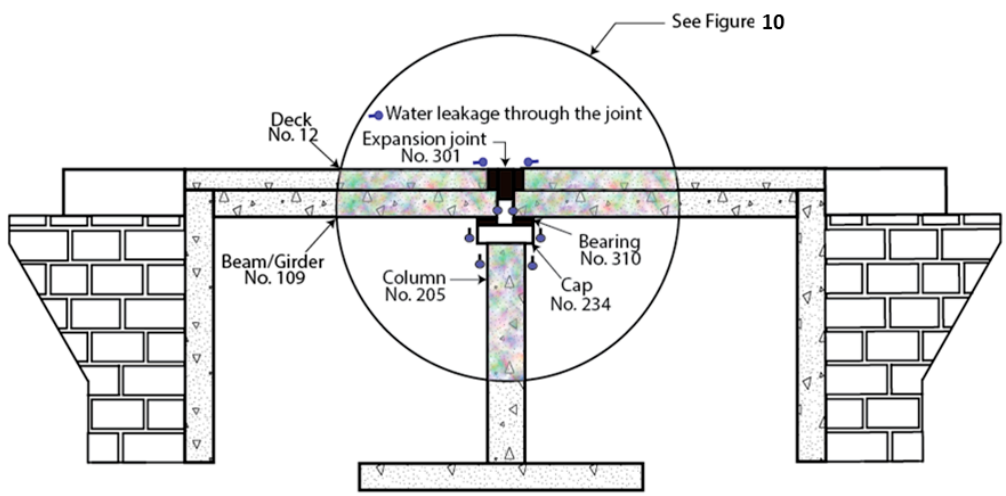
Figure 9. A two-span bridge with a group of Co-Active elements in the group PC109.